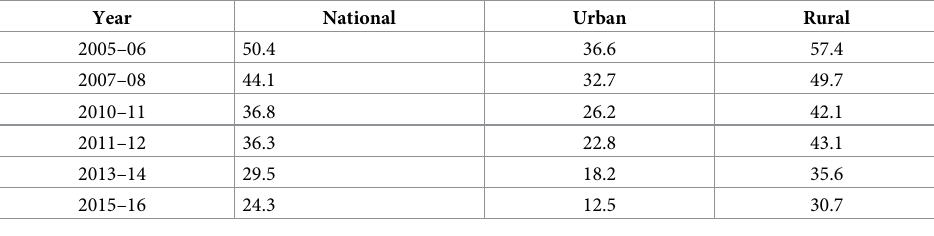
Table 1. Poverty trends in Pakistan, 2005–06 to